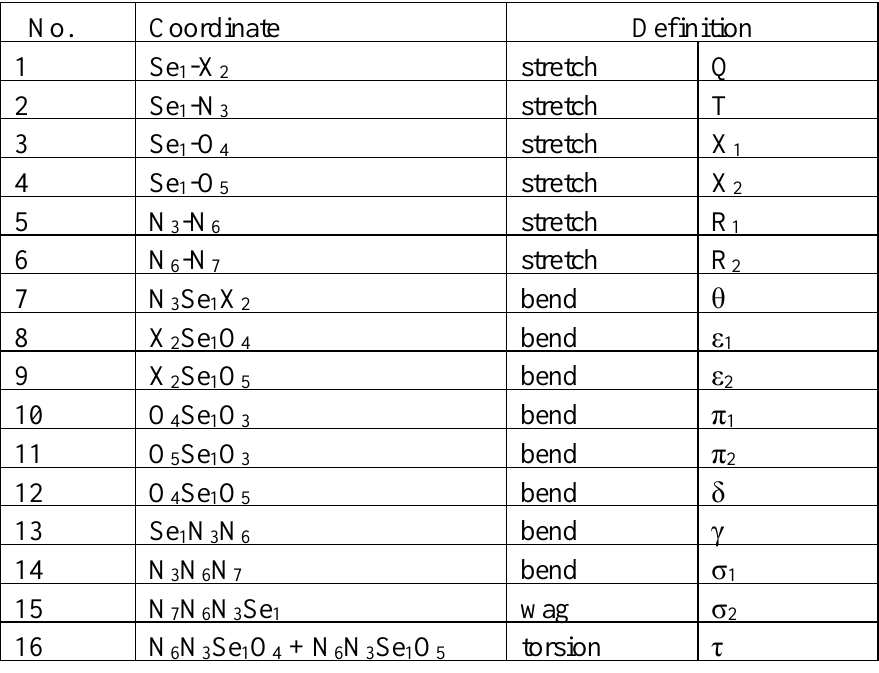
Table 3 : Over-complete set of internal coordinate definitions for haloselenonyl azides (X = F, Cl or Br; for atom denotation see Figure